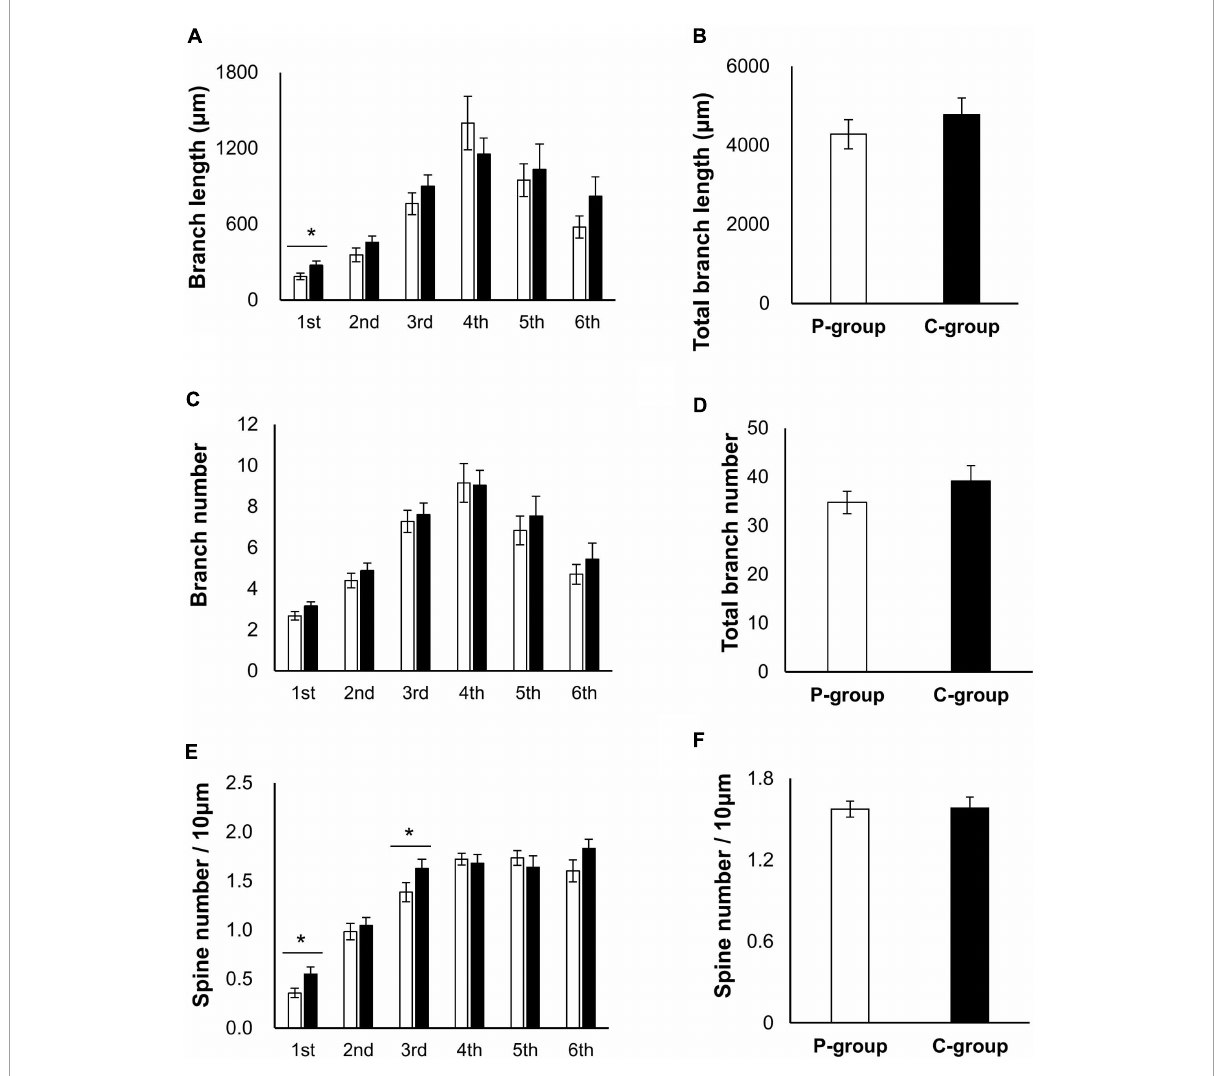
FIGURE4 Effect of mastication stimuli on the basal dendrites of CA1 pyramidal cell. (A) Branch length of dendrites. Branch numbering is illustrated in Supplementary Figure 2 . *: significant differences detected by Student t -test [ t (48) = 2.2613 and p = 0.0283 for the first branch]. (B) Total branch length of dendrites. (C) Branch number of dendrites. (D) Total branch number of dendrites. (E) Spine number per branch length. *: significant differences detected by Student t -test [ t (48) = 2.6018 and p = 0.0123 for the first branch and t (48) = 2.4425 and p = 0.0183 for the third branch]. (F) Total branch density per dendrite length. (cid:3) : P-group, (cid:4) : C-group. Sample numbers were n = 17–25 for each